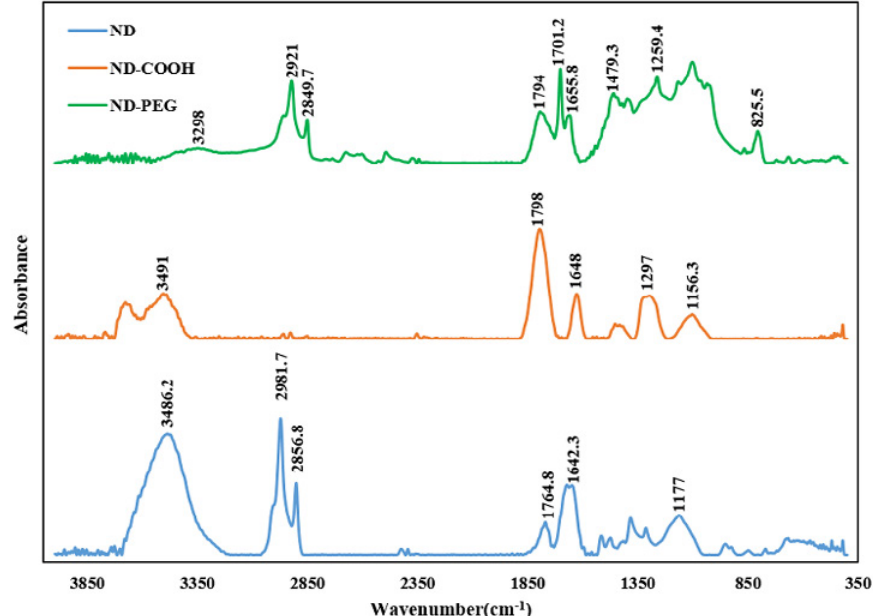
Fig. 1. The FT-IR spectra of pristine ND, ND-COOH and ND-PEG